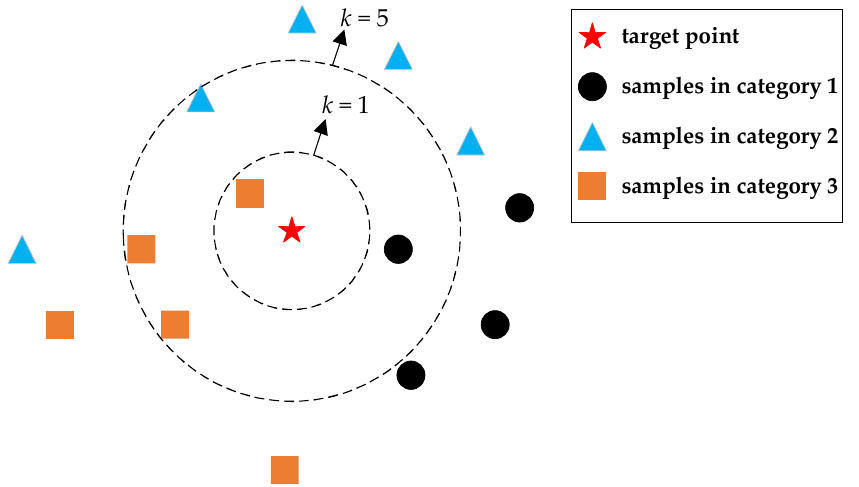
Figure 10. k -nearest neighbors classification presented in 2-dimensional form.